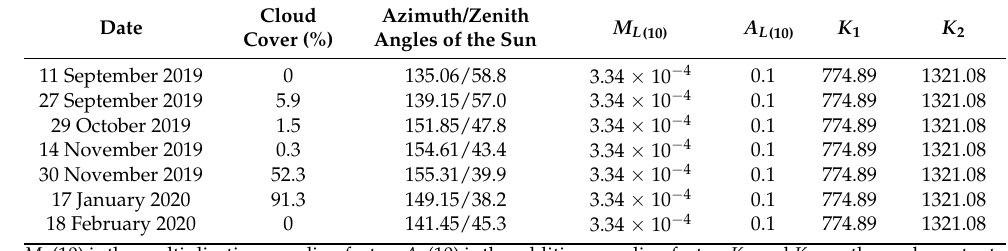
Table 1. Metadata for Landsat 8 images.